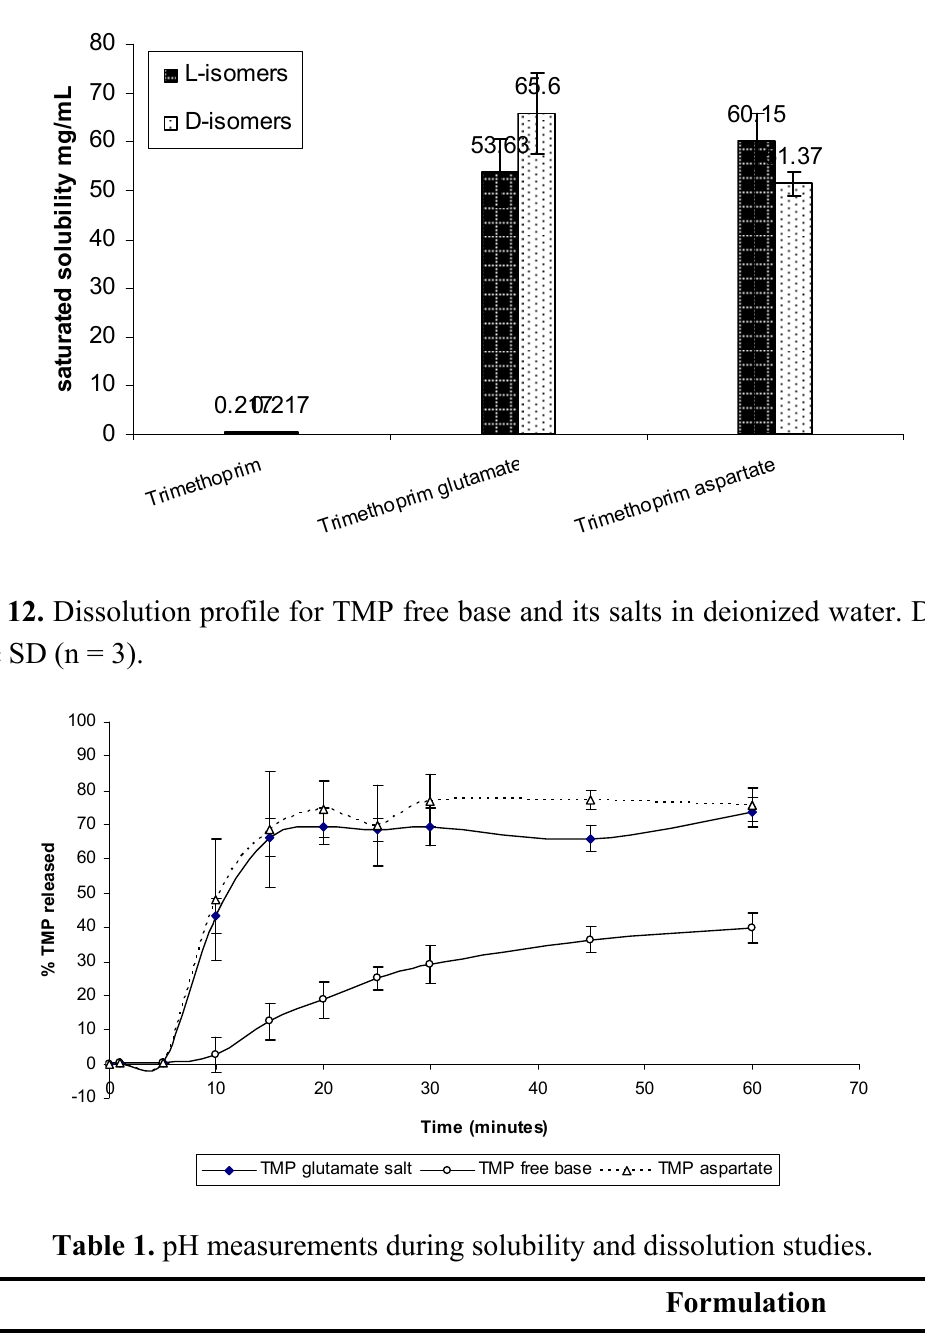
Figure 11. Solubility of trimethoprim and its prepared L & D aspartate and glutamate salts mean ± SD (n = 3).